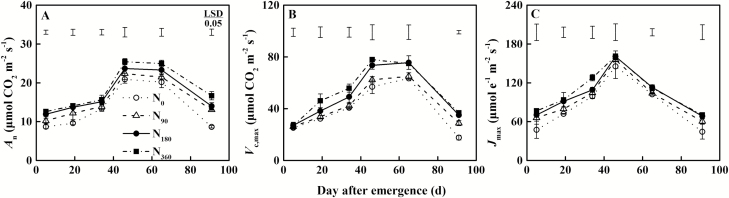
Dynamics of leaf (A) net photosynthetic rate (An), (B) maximum carboxylation rate (Vc,max), and (C) maximum electron transport rate (Jmax) along with the growth days of marked leaves of winter oilseed rape (Brassica napus L.) under different N supply. The bars at the top of the graph indicate the least significant difference (LSD) among treatments (P<0.05). Each point represents the mean of three repetitions per treatment and bars represent the SD.